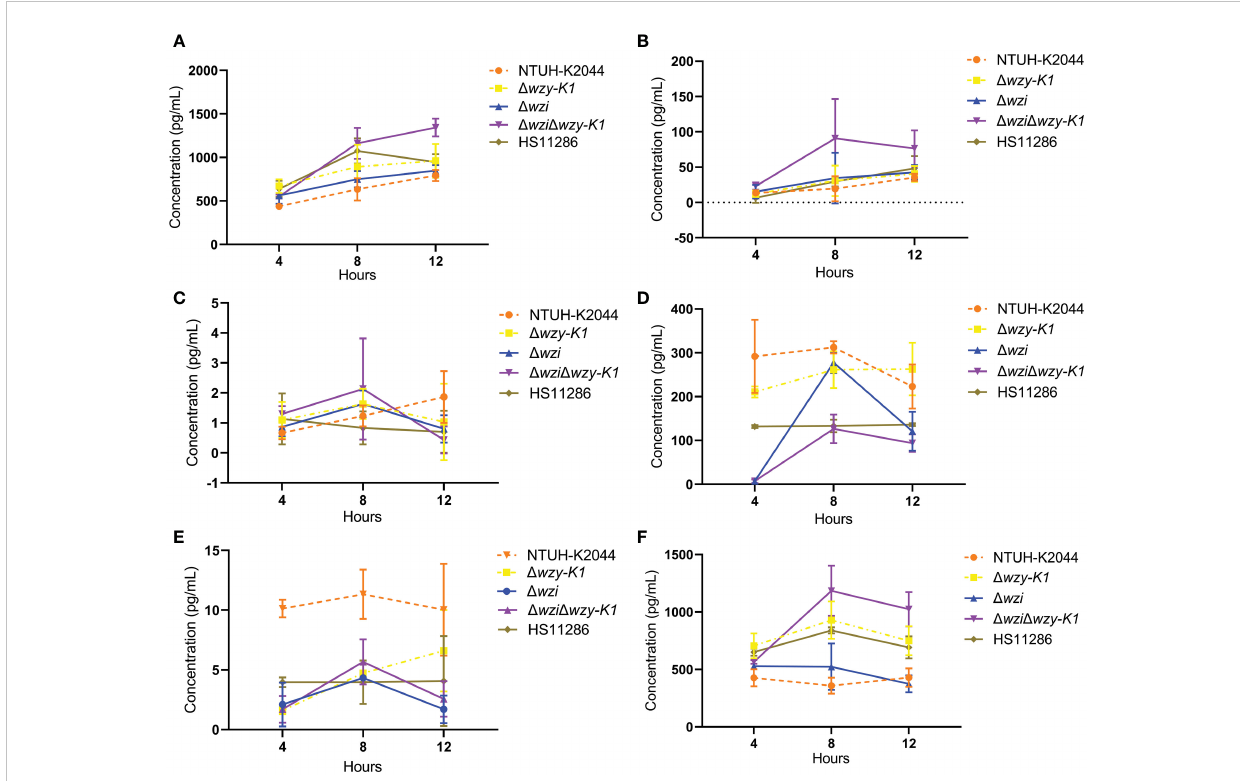
FIGURE 4 Effects of deletions of wzi , wzy-K1 , and wzi+wzy-K1 in Klebsiella pneumoniae on cytokine secretion by Kupffer cells. (A) IL-6 secretion; (B) IL-12 secretion; (C) IL-10 secretion; (D) TGF- b secretion; (E) IL-1 b secretion; (F) TNF- a secretion. IL: interleukin; TGF- b : transforming growth factor-beta; TNF- a : tumor necrosis factor-alpha. NTUH-K2044 and HS11286 were used as positive and negative controls, respectively. Homogeneity test of variance showed p = 0.0106 using Levene ’ s test. Kruskal-Wallis test presented a p value of 0.4576 among the 5 groups (A) . The factorial design analysis of variance showed signi fi cant differences among the 5 groups: F = 9.7138, p = 0.0018; further one-one comparisons con fi rmed all p values > 0.05; Comparison of each time point suggested F = 9.0737 and p = 0.0092. Analysis of interaction between groups and time points showed F = 0.8345, p = 0.5834 (B) . ANOVA showed no signi fi cant differences among the 5 groups: F = 0.7462, p = 0.5823; Analysis of interaction between groups and time points showed F = 1.1687, p = 0.3644 (C) . Normality test showed p = 0.0192 using Kolmogorov-Smirnov test. Kruskal-Wallis